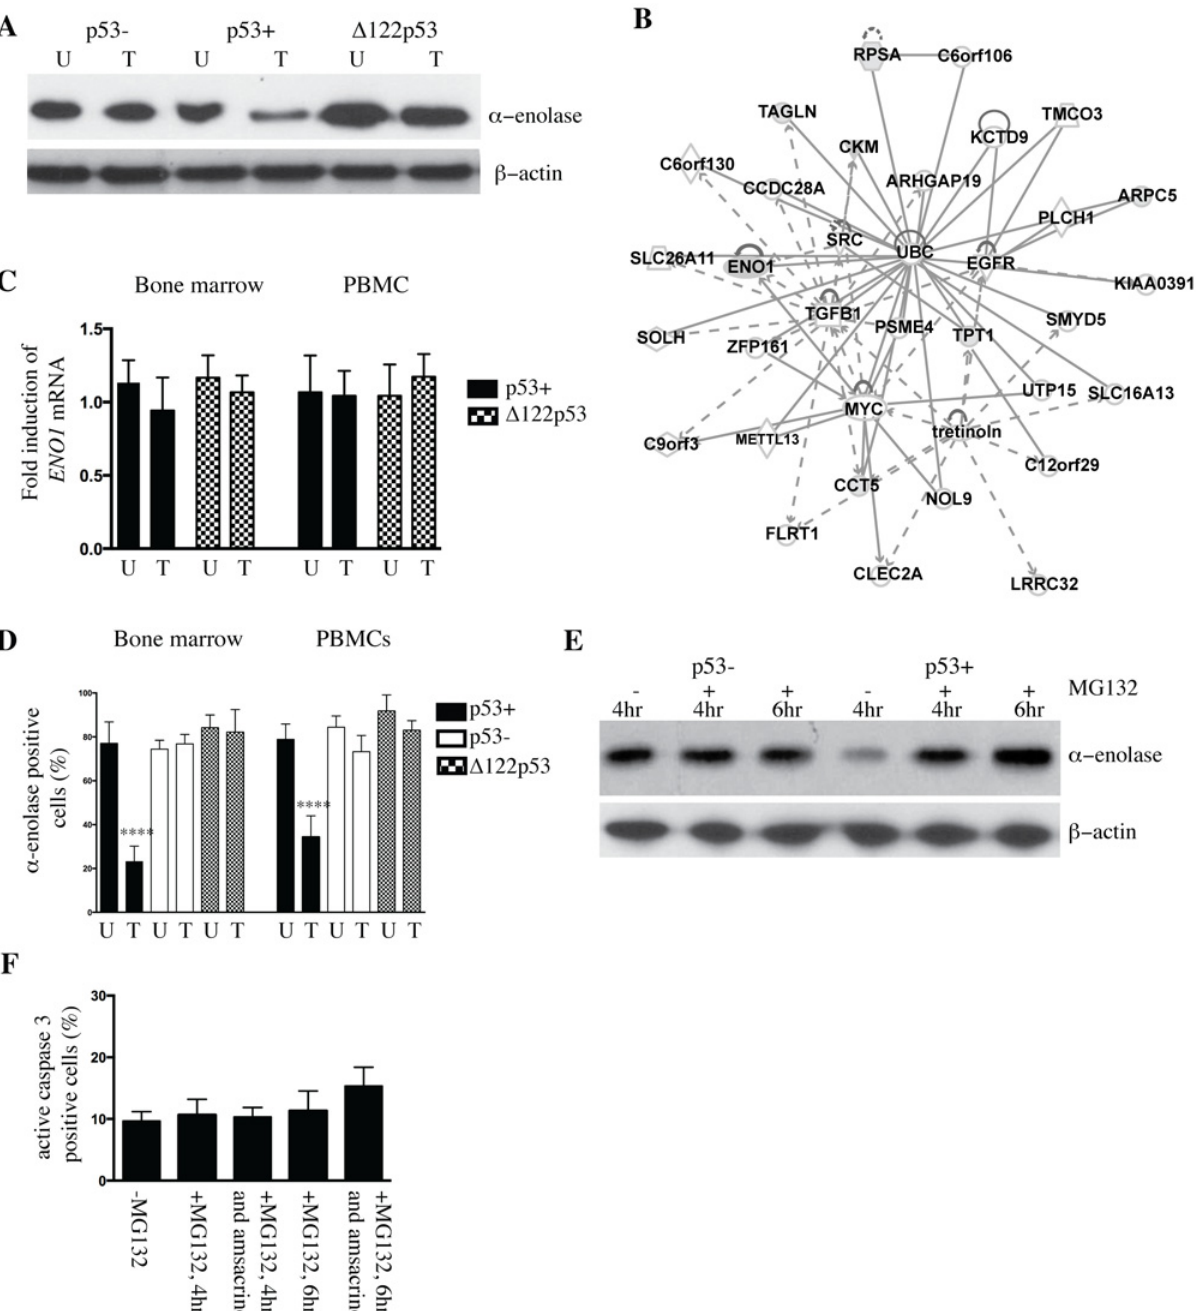
Figure 1. Altered abundance of alpha-enolase in p53+ and Δ 122p53 bone marrow. A. Alpha-enolase is decreased in wild-type p53 (p53+) bone marrow upon DNA damage with amsacrine treatment and increased in Δ 122p53 bone marrow cells irrespective of amsacrine treatment compared with p53 null (p53-) cells by western blotting. Amsacrine treated (T) or untreated (U). B. Network analysis of the differentially expressed proteins in p53+ bone marrow untreated and p53+ bone marrow treated with amsacrine from two-dimensional fluorescence difference gel electrophoresis using Ingenuity Pathways Analysis software. Gray shading indicates proteins identified in the current study. Solid and dashed lines indicate direct and indirect interactions, respectively. C. The decrease in α -enolase in p53+ treated bone marrow was not due to reduced expression of ENO1 . No significant differences were found in the amounts of ENO1 transcript expressed in p53+ and Δ 122p53 bone marrow and peripheral blood mononuclear cells (PBMCs) in untreated cells (U) and cells treated with amsacrine (T) using real-time PCR. The results are expressed as the mean ± SD, from 3 mice per genotype and represent the fold increase in ENO1 expression, normalized for beta2-M expression. D. The percentage of alpha-enolase positive cells was reduced in p53+ bone marrow and peripheral blood mononuclear cells (PBMCs) treated with amsacrine. Bone marrow and PBMCs from five mice per genotype were extracted and treated with amsacrine